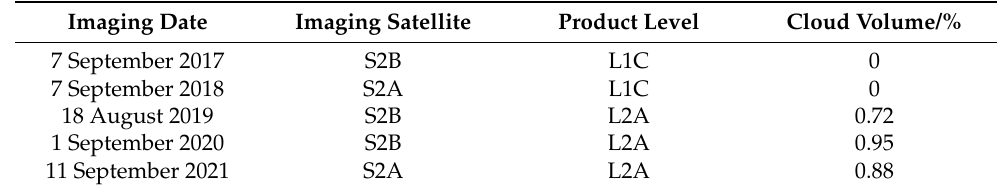
Table 1. Time-series Sentinel-2 data.